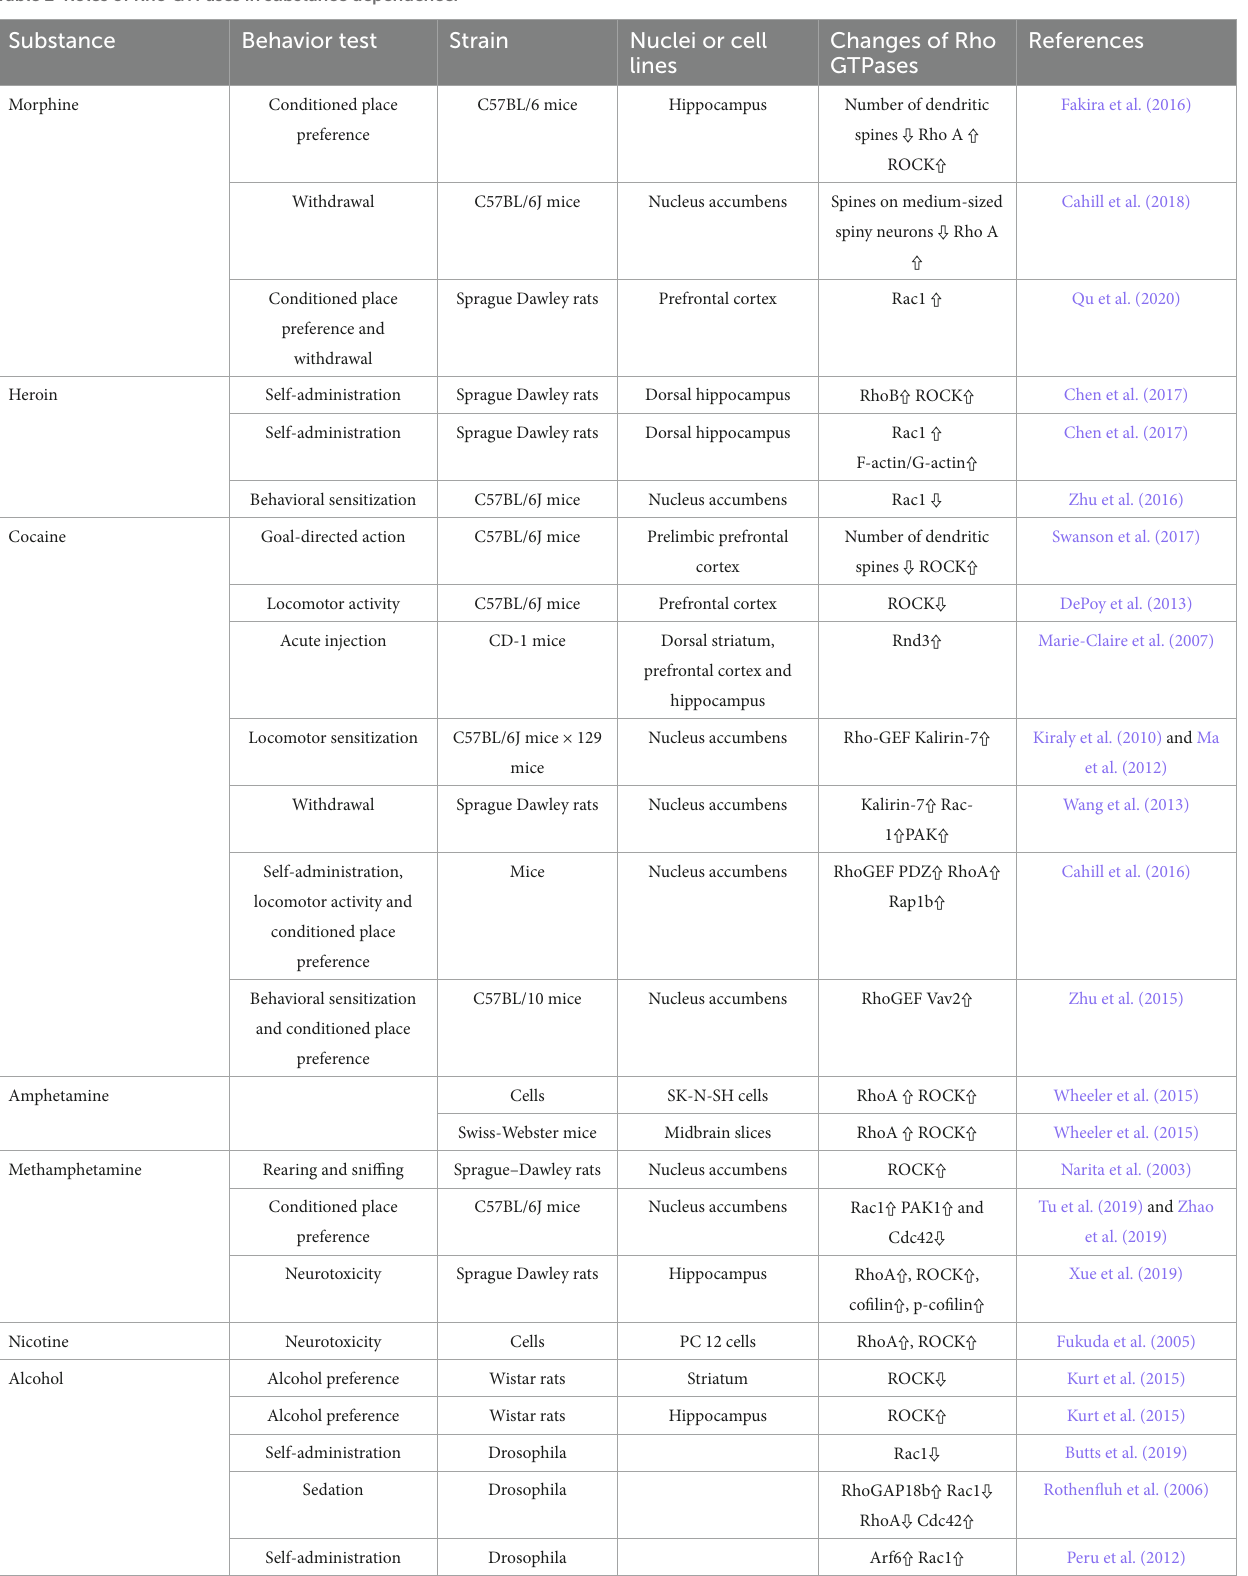
Table 2 Roles of Rho GTPases in substance